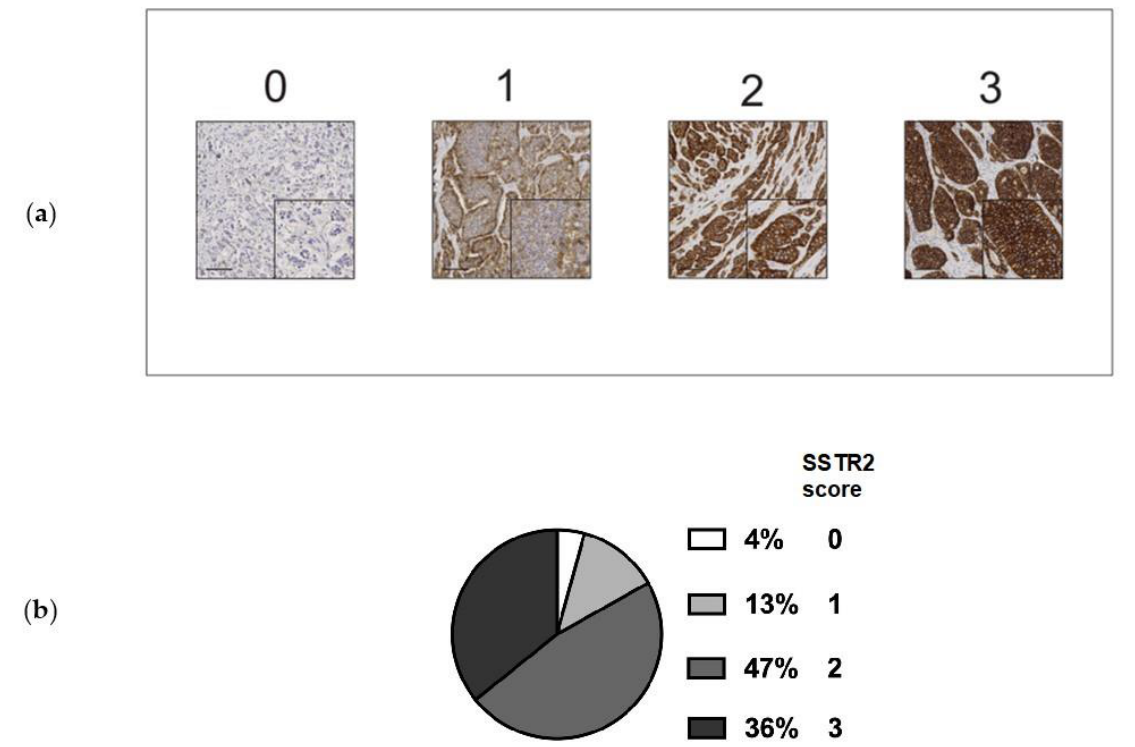
Figure 3. ( a ) Representative images of SSTR2 scoring 0–3. Size bar = 100 µ m. Insert shows magnification. ( b ) Distribution of SSTR2 score in tumor samples ( n = 95) from PRRT treated patients.